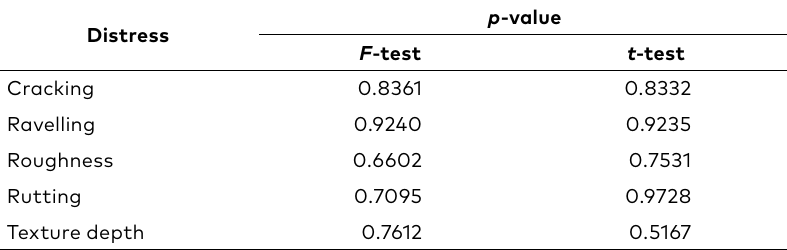
Table 2. Results of validation using Student’s